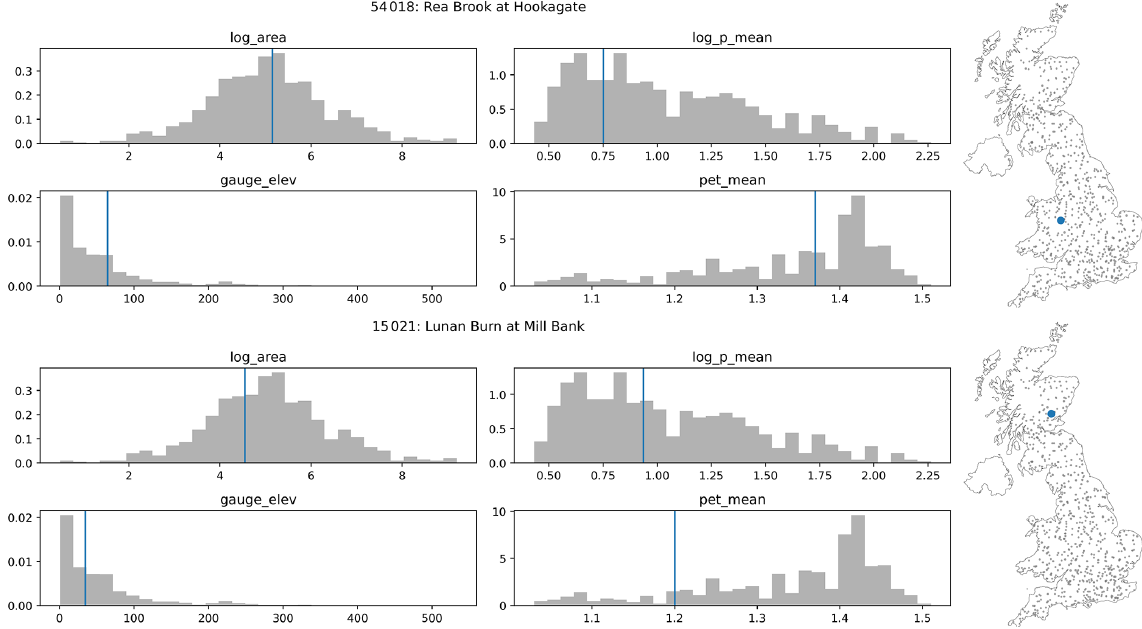
Figure D1. The spatial context of the two demonstration catchments shown in the figures in the sections above. For both Gauge ID: 54018, Rea Brook at Hookagate (a) , and Gauge ID: 15021, Lunan Burn at Mill Bank (b) , we show the log area, the log mean precipitation, the gauge elevation, and the mean potential evapotranspiration as well as the location of the station on the map on the